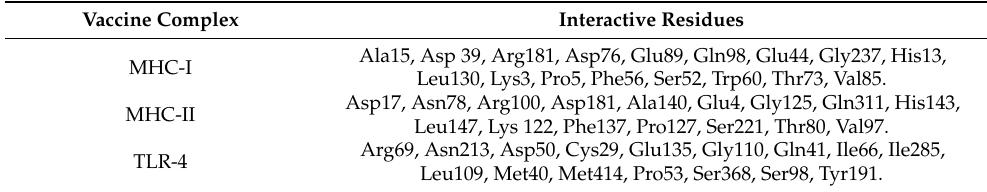
Table 9. Vaccine molecules interact with receptor residues.